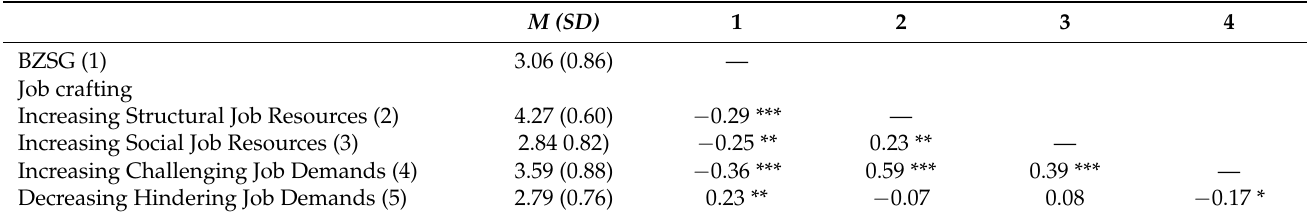
Table 1. Descriptive Statistics and Simple Correlations between Belief in a Zero-Sum Game (BZSG) and Four Types of Job-Crafting